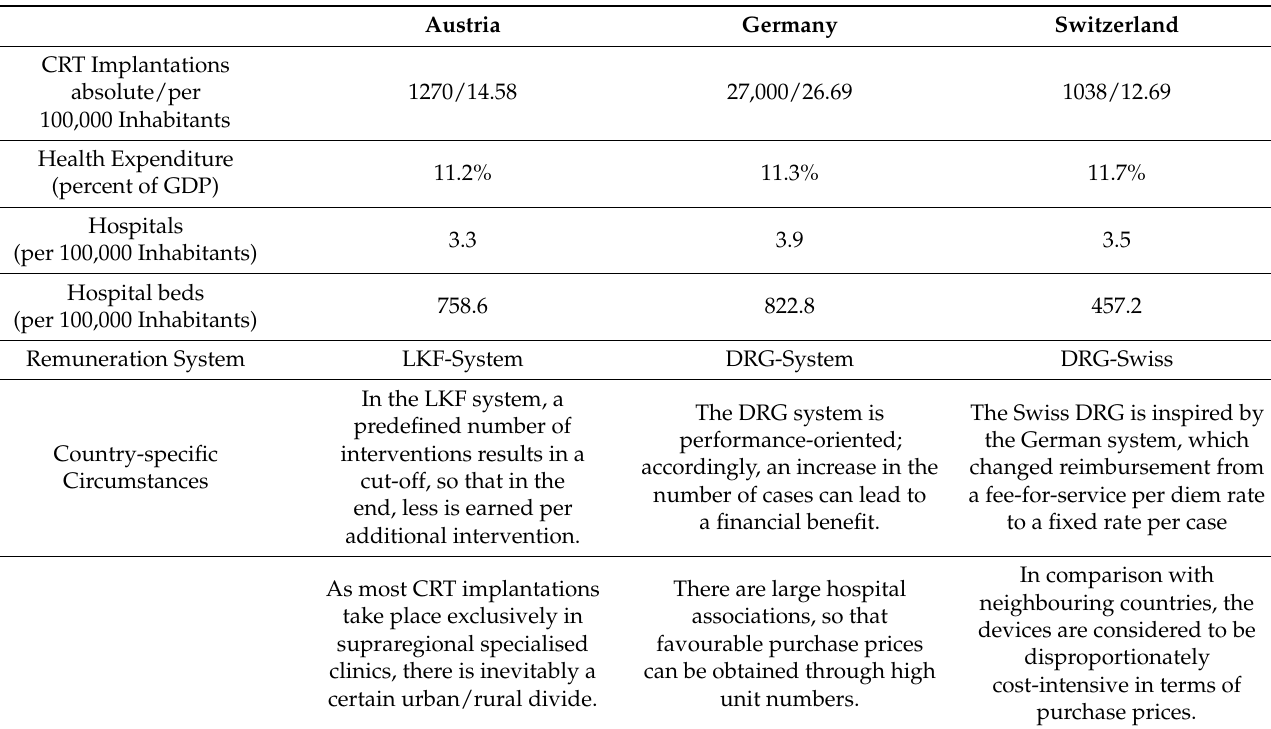
Table 1. Background information on the respective